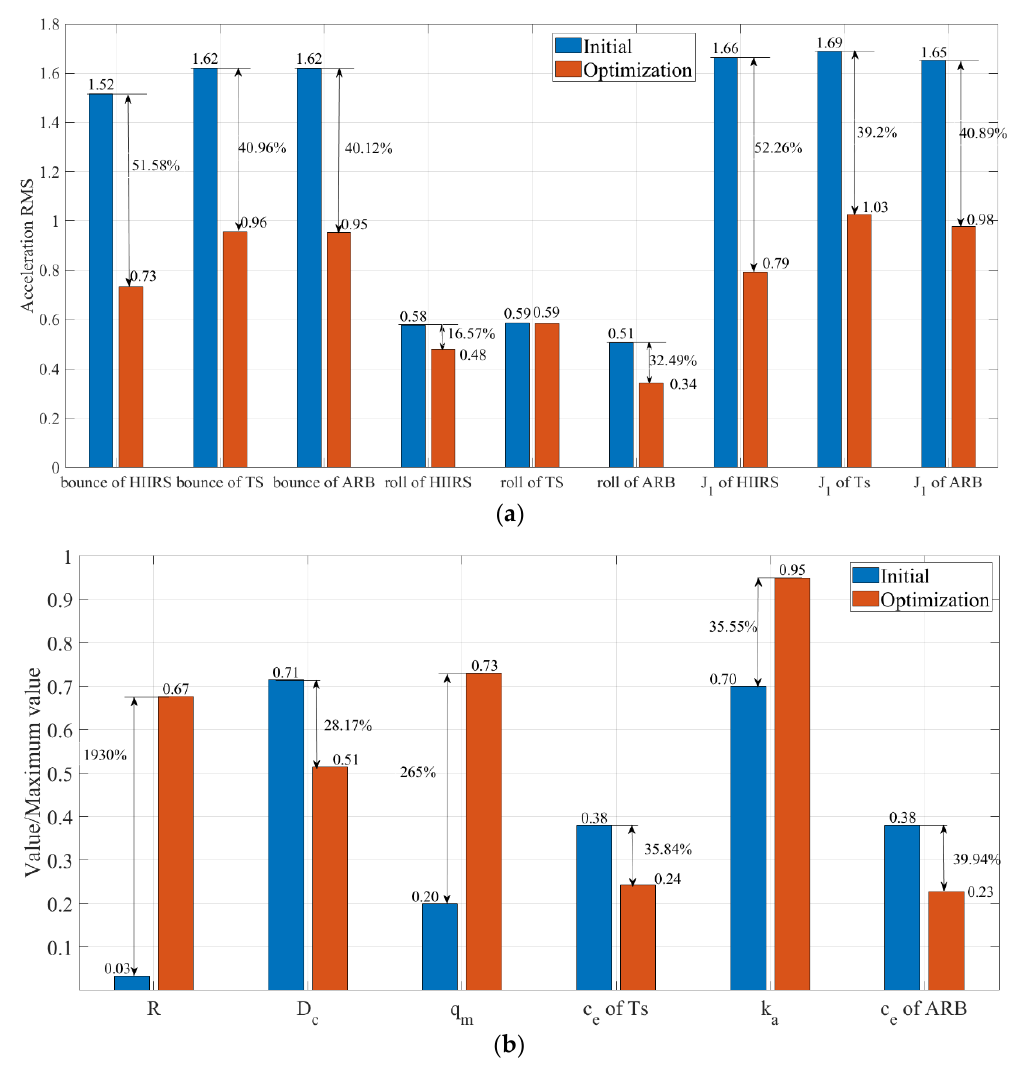
Figure 5. Performances and parameters comparison ( a ) performance comparison; ( b ) parameters comparison.